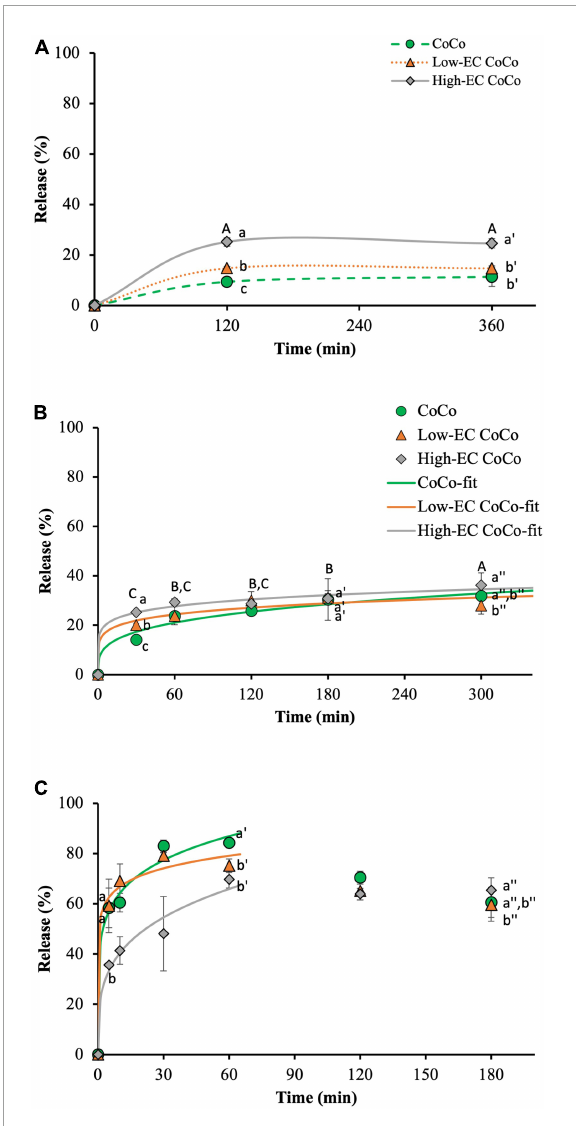
FIGURE6 The release of limonene from CoCo, low-EC CoCo and high-EC CoCo microcapsules in water at room temperature (A) , SGF at 37 ◦ C (B) and SIF at 37 ◦ C (B) . Lines are drawn to guide the eye in panel (A) , fits to Equation 1 for the 5 h release of limonene in SGF and the first 1 h release in SIF are shown in panels (B,C) . Different letter indicates statistically significant differences between different formulations at selected time points or between different time points in CoCo and low-EC CoCo.